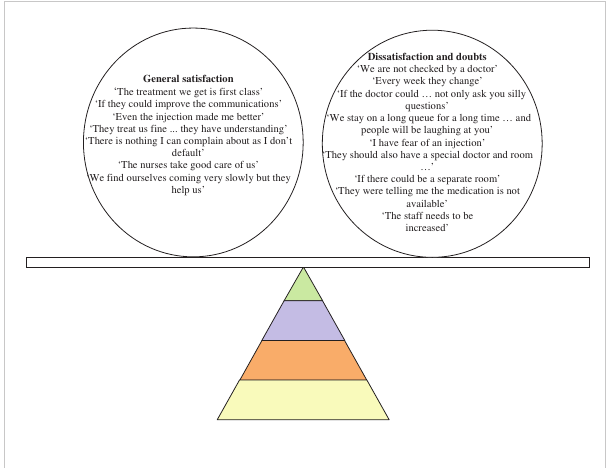
Fig.1.Satisfactionversusdissatisfactionwithmentalhealthcare.